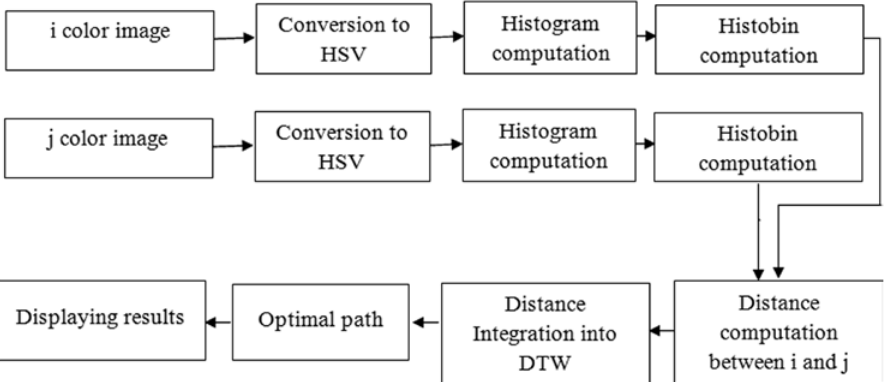
Figure 3: The schema of the proposed